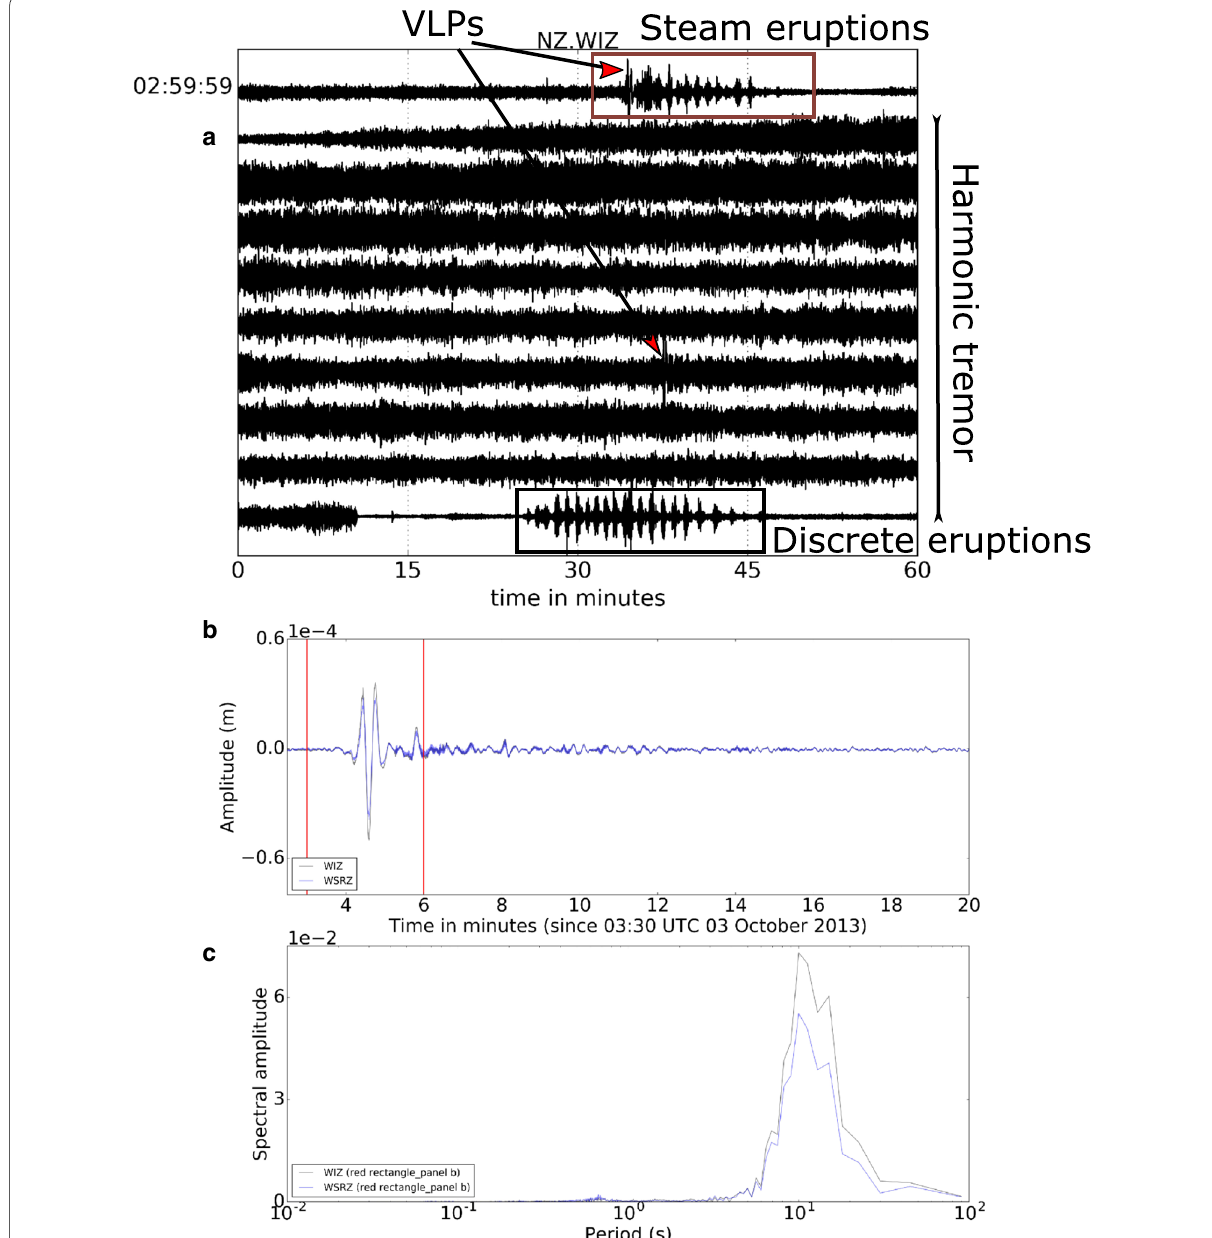
Fig. 5 Seismicity and VLPs recorded at White Island. a Vertical velocity seismogram b displacement corresponding to the red rectangle in a c spectrum corresponding to the red rectangle in b, after removing the offset, the trend and high-pass filtering below 100 s. The steam eruption was observed visually on the GeoNet Web Camera system while late stage discrete eruptions have seismo-acoustic signatures similar to small scale mud eruptions occurring in early 2013 (Jolly et al. 2016). VLPs have a dominant period of ∼ 10 s [subplot ( c